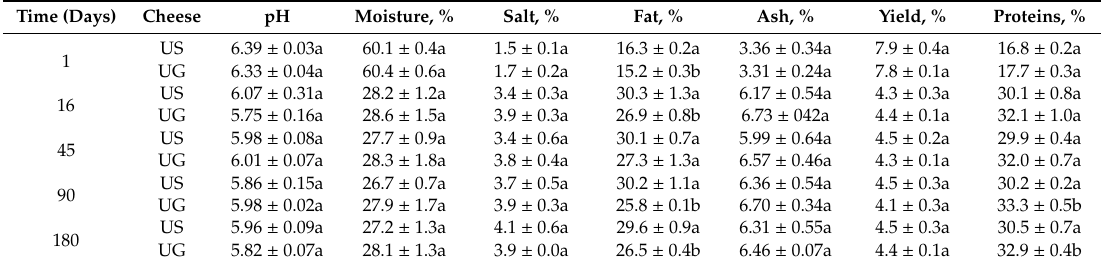
Table 2. Changes of physicochemical characteristics of Urda cheese made from 100% sheep (US) or a mixture of 90% sheep–10% goat (UG) whey during ripening and